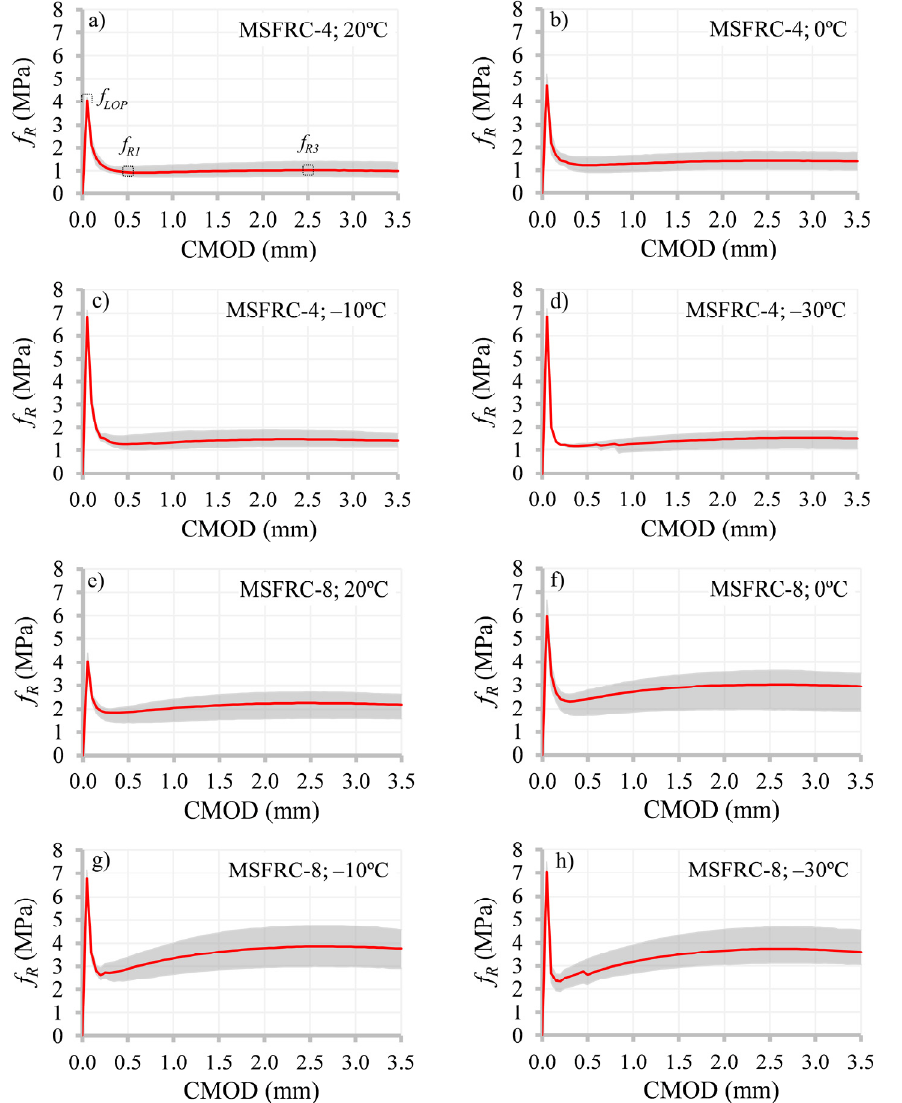
Figure 3. Flexural pre- and post-cracking strength at different temperatures of: ( a – d ) MSFRC-4; ( e – h ) MSFRC-8.